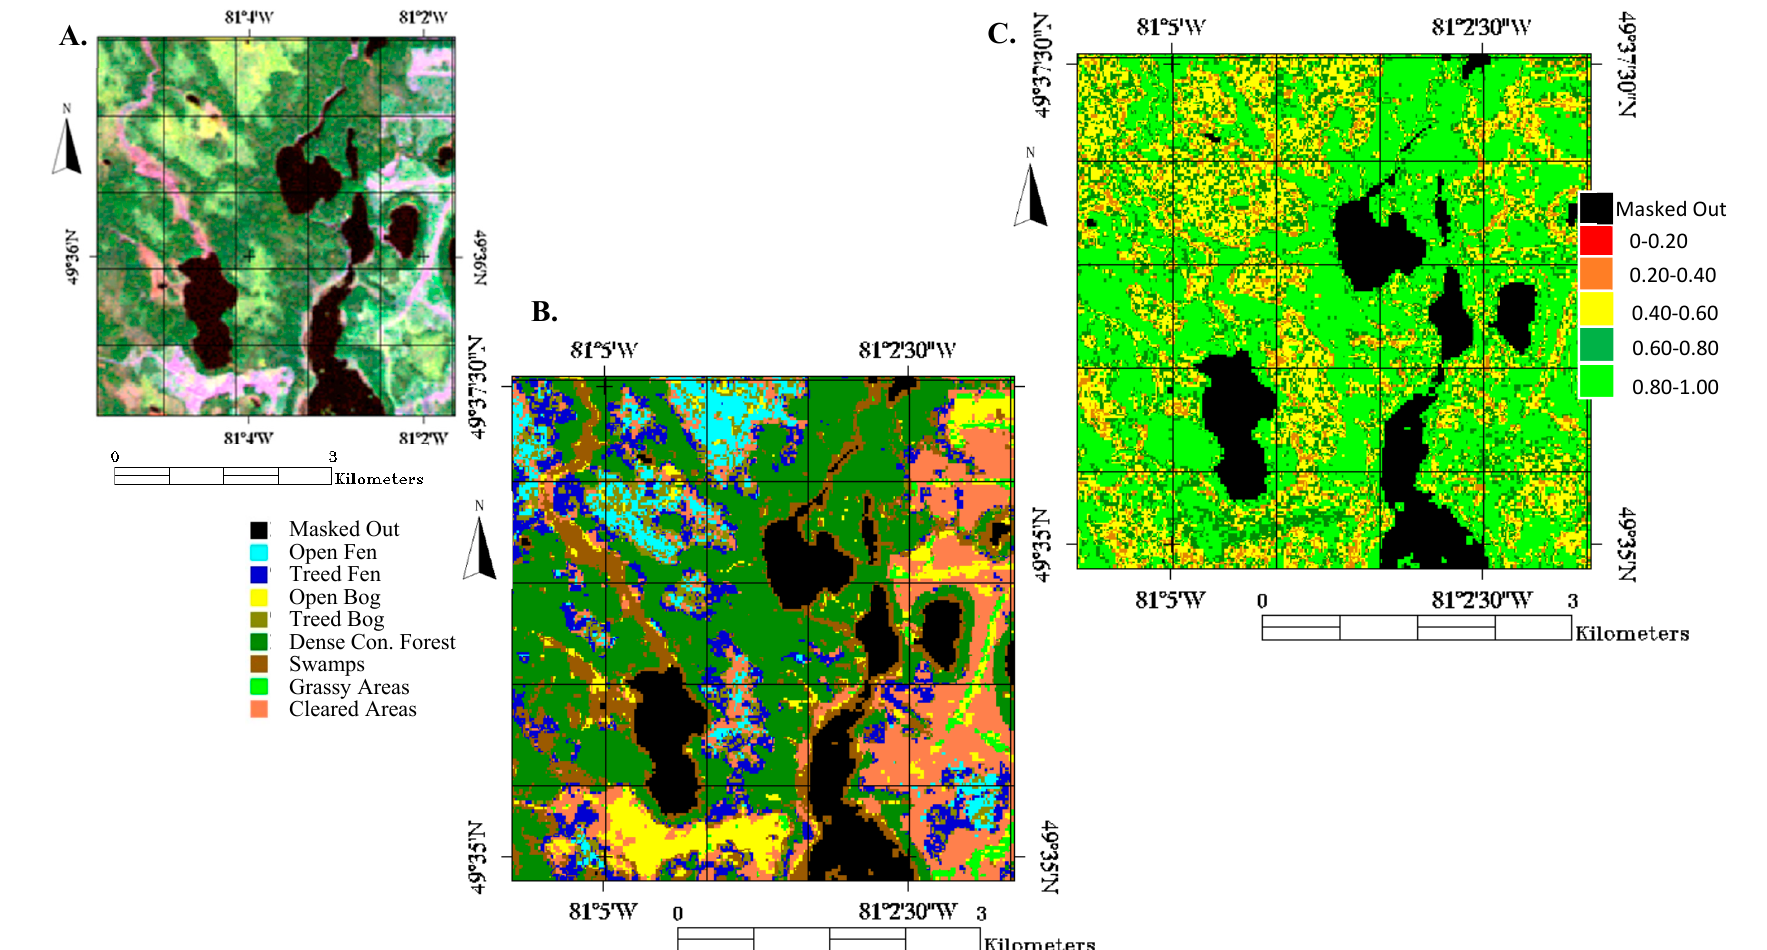
Figure 6. Output from classification result. ( A ) True color Landsat-5 image from a given test area. ( B ) Resulting classification result. ( C ) Confidence map of the classification